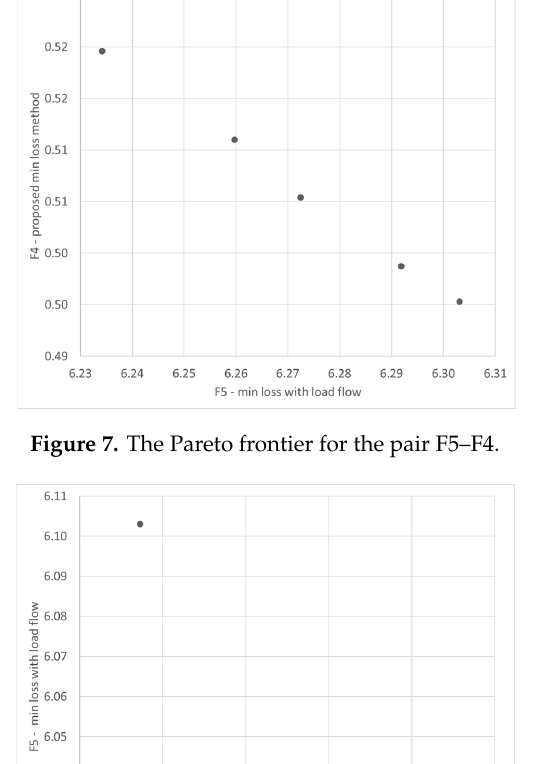
Figure 6. The Pareto frontier for the pair F1–F3.